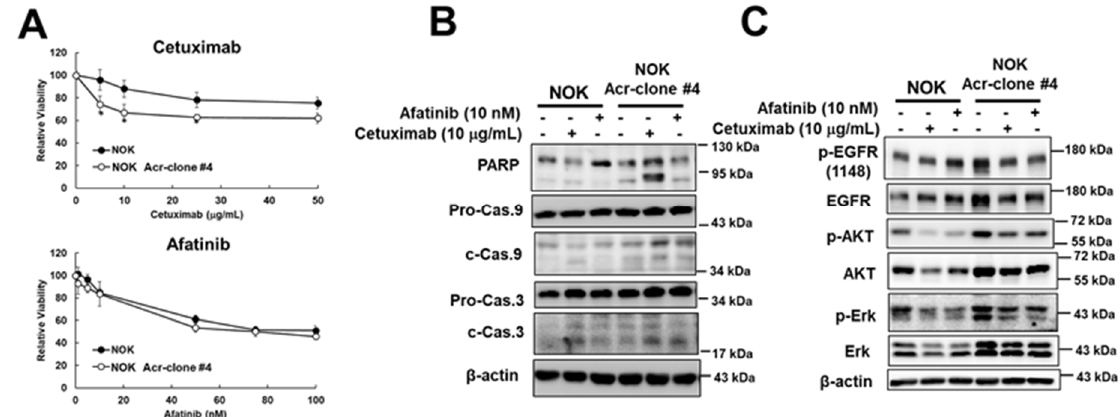
Figure 4. Cetuximab, an anti-EGFR antibody, can induce apoptosis and inhibit EGFR activation in acrolein-transformed